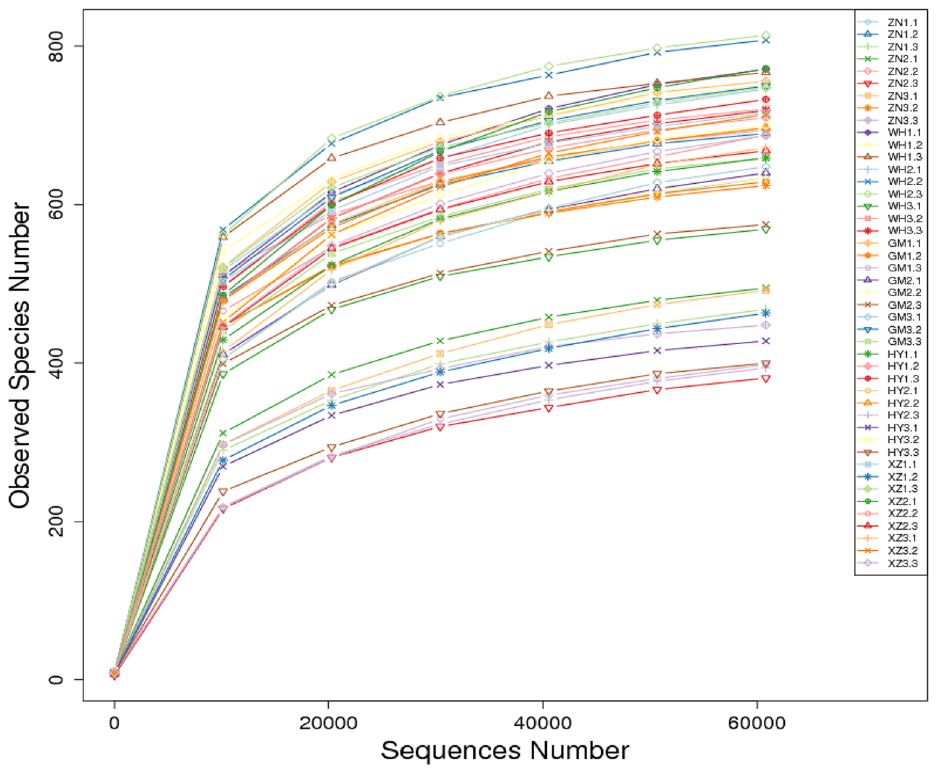
Figure 1. Rarefaction curves at the OTUs similarity of 97%. In Fig. 1, the OTUs similarity of the samples is 97%. The abbreviations ZN, XZ, HY, WH, and GM represent the planting years of 5, 8, 10, 12 and 15, respectively. The first digit of sample name indicated the replicate number and the second indicated the soil depth (1, 2 and 3 denoted the soil depth of 5–20, 20–35 and 35–50 cm, respectively).